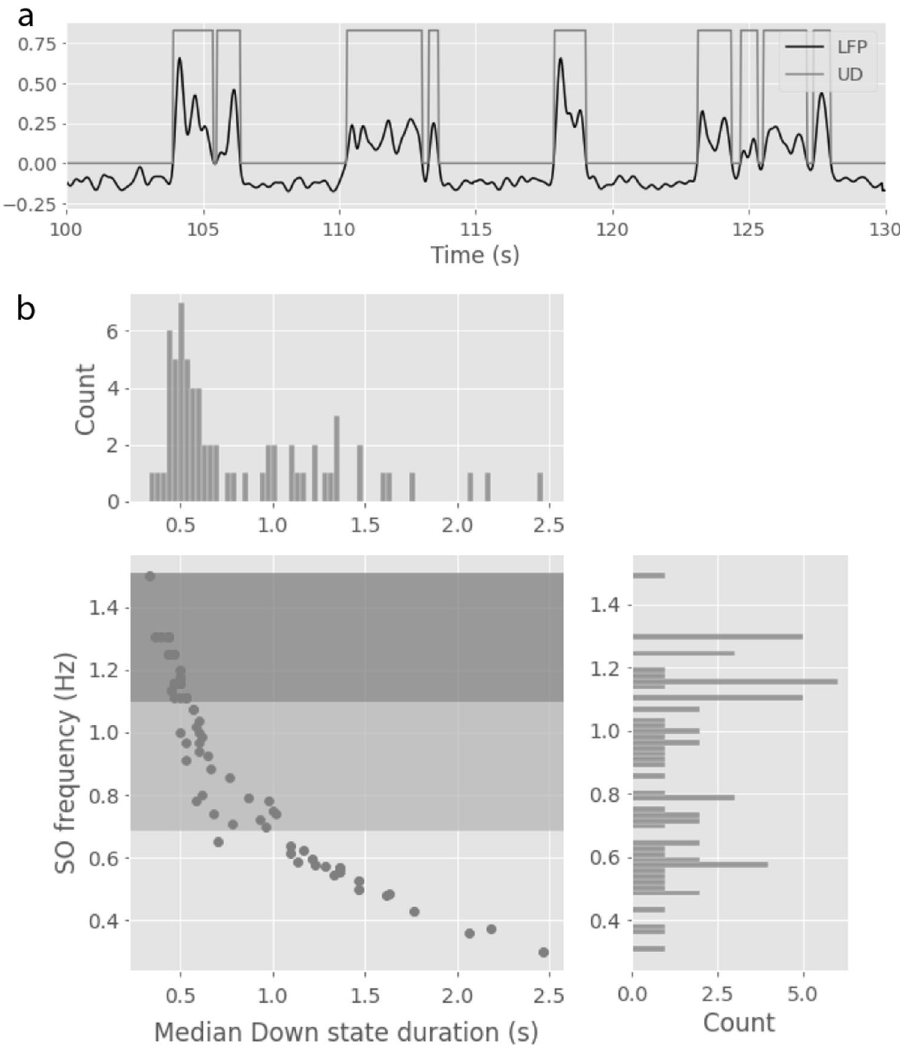
Figure 3. Up and Down state dynamics in the LFP. a. Example of Up and Down state detection in a 30 seconds recording using the normalized LFP signal (arbitrary units). b. Relationship between SO frequency and Down state duration across recordings. Definition of three groups of recordings of decreasing slow oscillation frequency. Data from 67 recordings (8 mice).